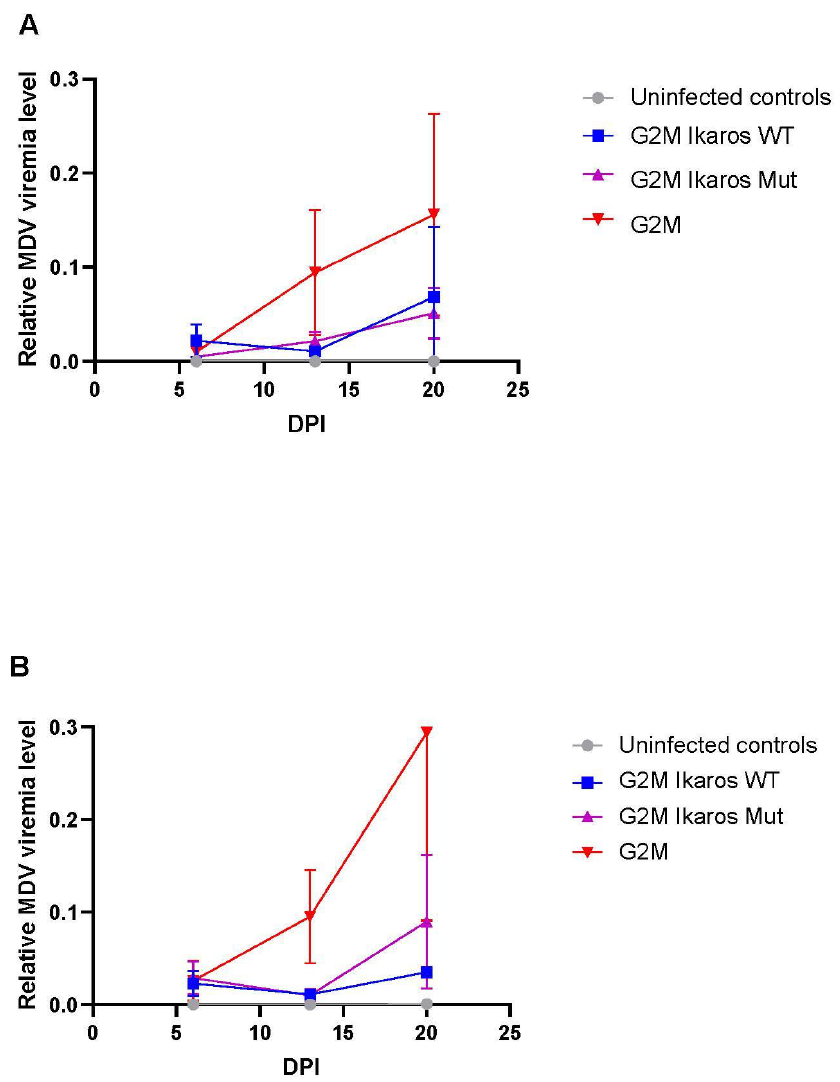
Figure 4. In vivo replication of recombinant viruses across treatment groups based on qPCR of PBLs ( n = 5 birds per timepoint) for both Replicate 1 ( A ) and Replicate 2 ( B ). MDV viremia levels are the ratio of MDV UL27 (glycoprotein B) to GADPH levels.